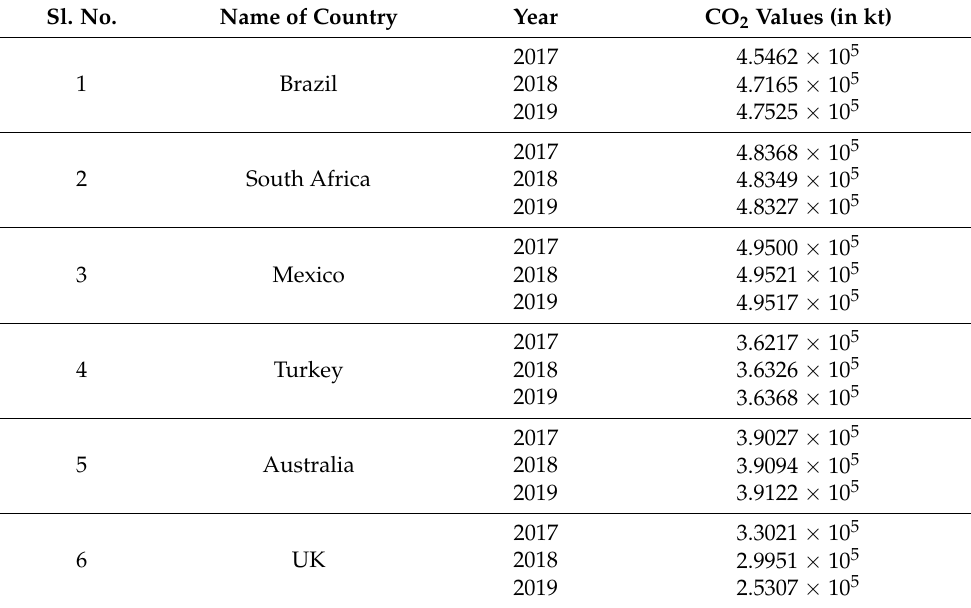
Table 5. Predicted CO 2 emission values for the year 2017–2019 for Group-2 countries. Sl.